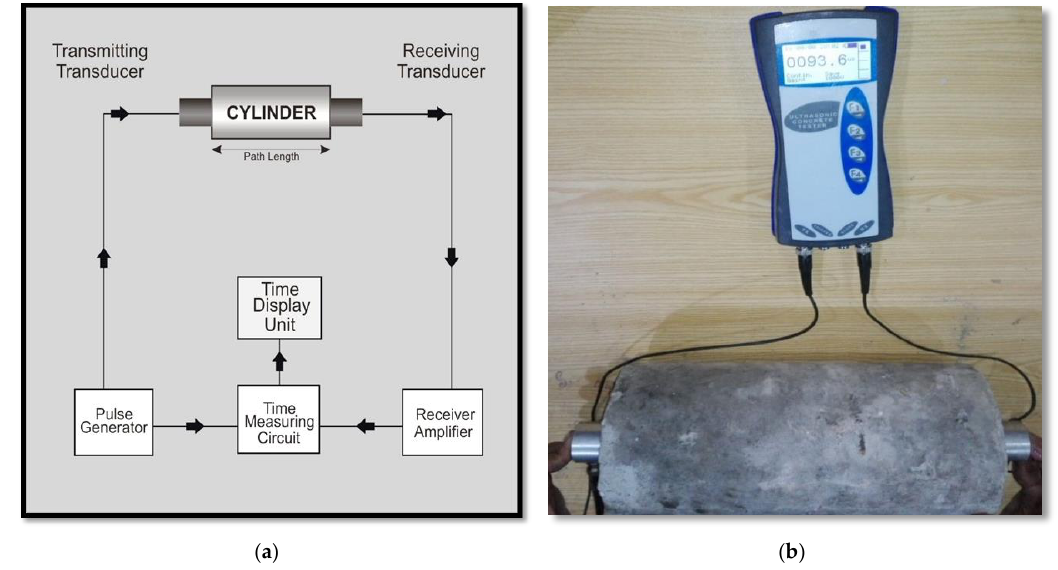
Figure 4. Ultrasonic Pulse Velocity Test: ( a ) UPV formal diagram, ( b ) Specimen testing. The pulse velocity and dynamic modulus of elasticity are to be calculated by Equations (1) and (2) that are listed in ASTM C-597.